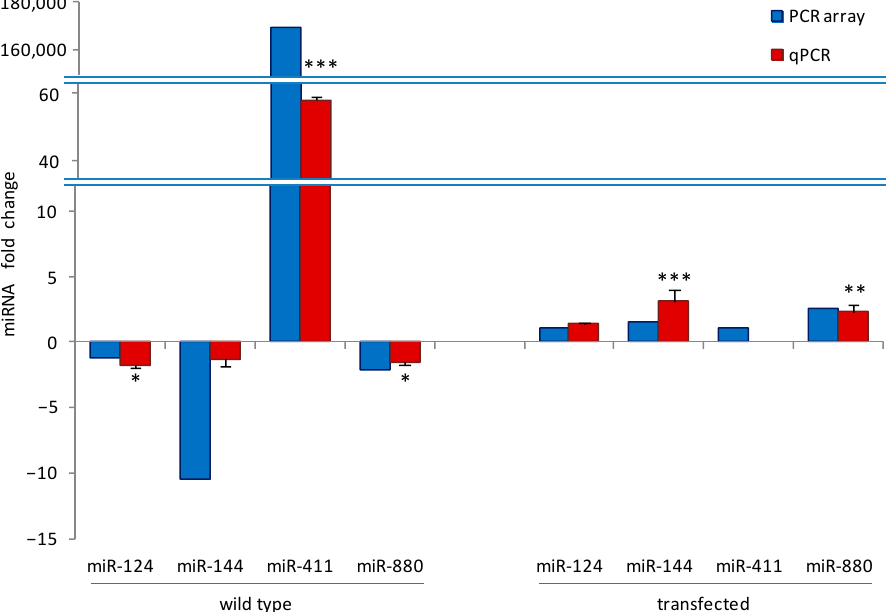
Figure 2. PCR arrays validation. QPCR data of the expression levels of miR-124-3p, miR-144-3p, miR-411-5p, and miR-880-3p in wild-type and transfected cells at 24h were compared with PCR array data to validate the trend of the expression changes. The PCR-array data reported here are the same as those reported in Tables 1 and 2, except for miR-124 and miR-144, which are under the threshold (fold change ≥ 2). For qPCR, the miRNAs expression is presented as fold change of RANKL ⁺ versus RANKL − cells in wild-type (control arbitrary set at 1) and in transfected RANKL ⁺ cells as fold change of NFATc1 siRNA versus negative control (NC)-siRNA (control arbitrary set at 1). Each bar of qPCR data represents the mean ± SD of at least two independent experiments. * p < 0.05, ** p < 0.01, and *** p < 0.001, each agent alone versus control. U6 snRNA was used as a housekeeping miRNA for qPCR experiments.